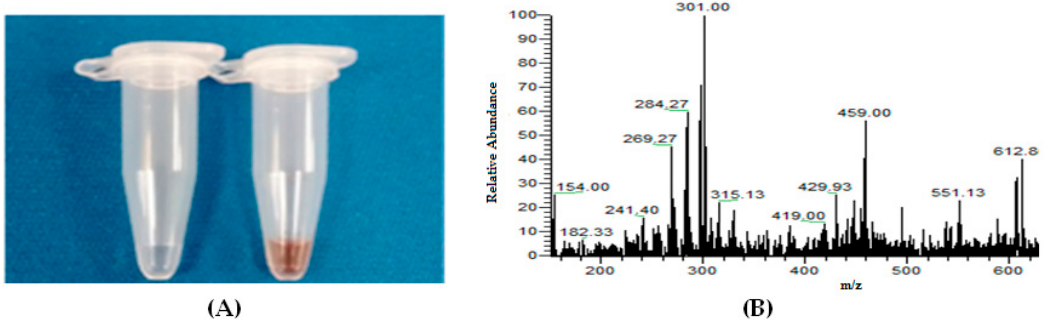
Figure 11. ( A ) Colour change after electrolysis; ( B ) Mass spectrum of DOPA electrochemical metabolism at 0.27 V.